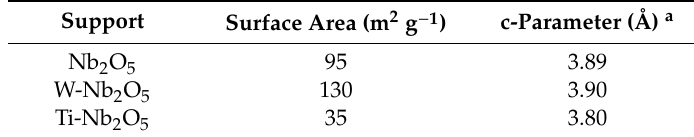
Table 2. Surface area and c-parameter of the di ff erent supports